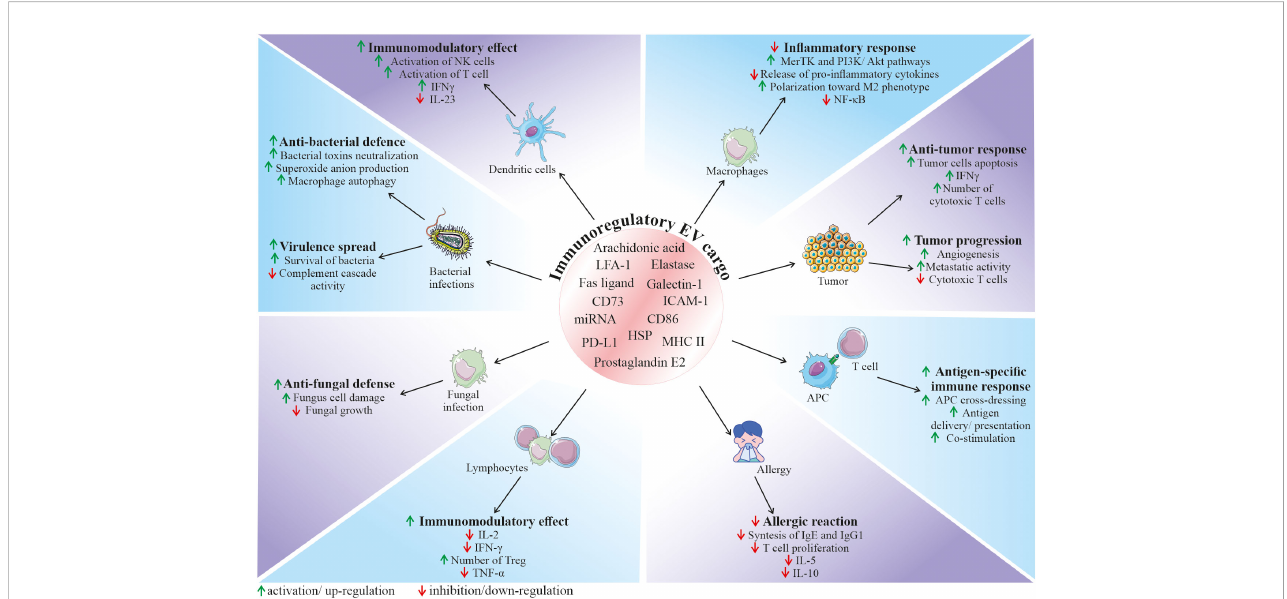
FIGURE 3 Role of EVs in the regulation of the immune response. Depending on the origin, EVs can contain and deliver a diverse bioactive cargo with immunoregulatory activity, that can in fl uence various cell types and modulate their functional status. It has been demonstrated that EVs may have an impact on many immune-related processes, including regulation of immune system activation status, mediation of anti-bacterial and anti-fungal defence, modulation of anti-tumor response, as well as inhibition of harmful overactivation of the immune system. APC, antigen presenting cells; ICAM- 1, intercellular adhesion molecule 1; HSP, heat shock protein; IFN- g , interferon gamma; LFA-1, lymphocyte function-associated antigen 1; MHC II, major histocompatibility complex class II; MerTK, mer receptor tyrosine kinase; NK cells, natural killer cells; PD-L1, programmed death-ligand 1; TNF- a , tumor necrosis factor alpha; Treg, regulatory T